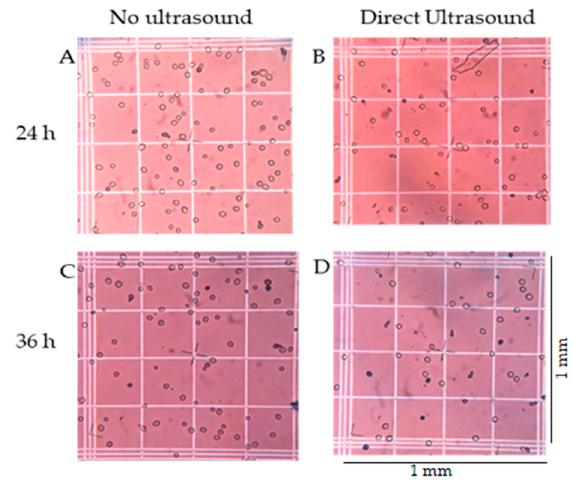
Figure 7. Effects of ultrasound on the percentage of viable cells during fermentation. No-ultrasound (N), indirect ultrasound (I), direct ultrasound 1 (D-1), and direct ultrasound 2 (D-2).